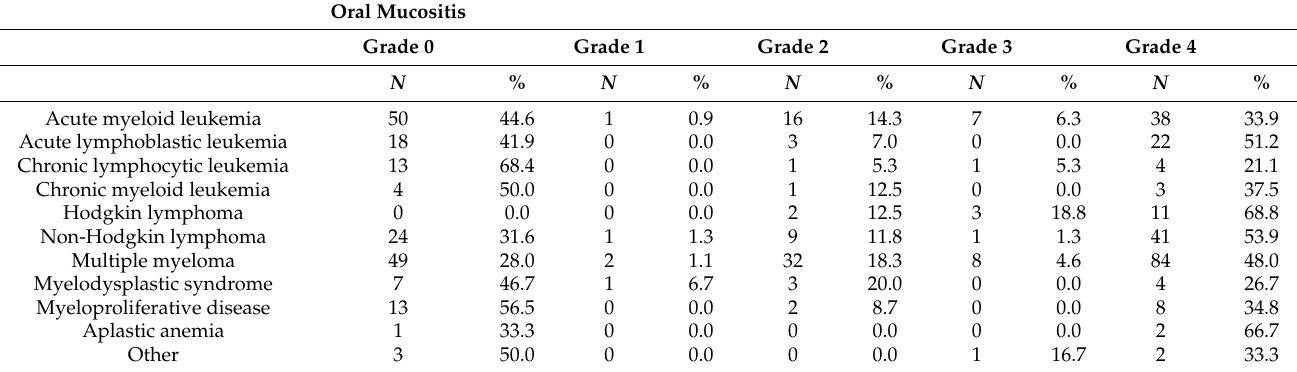
Table 4. Oral mucositis in specific disease